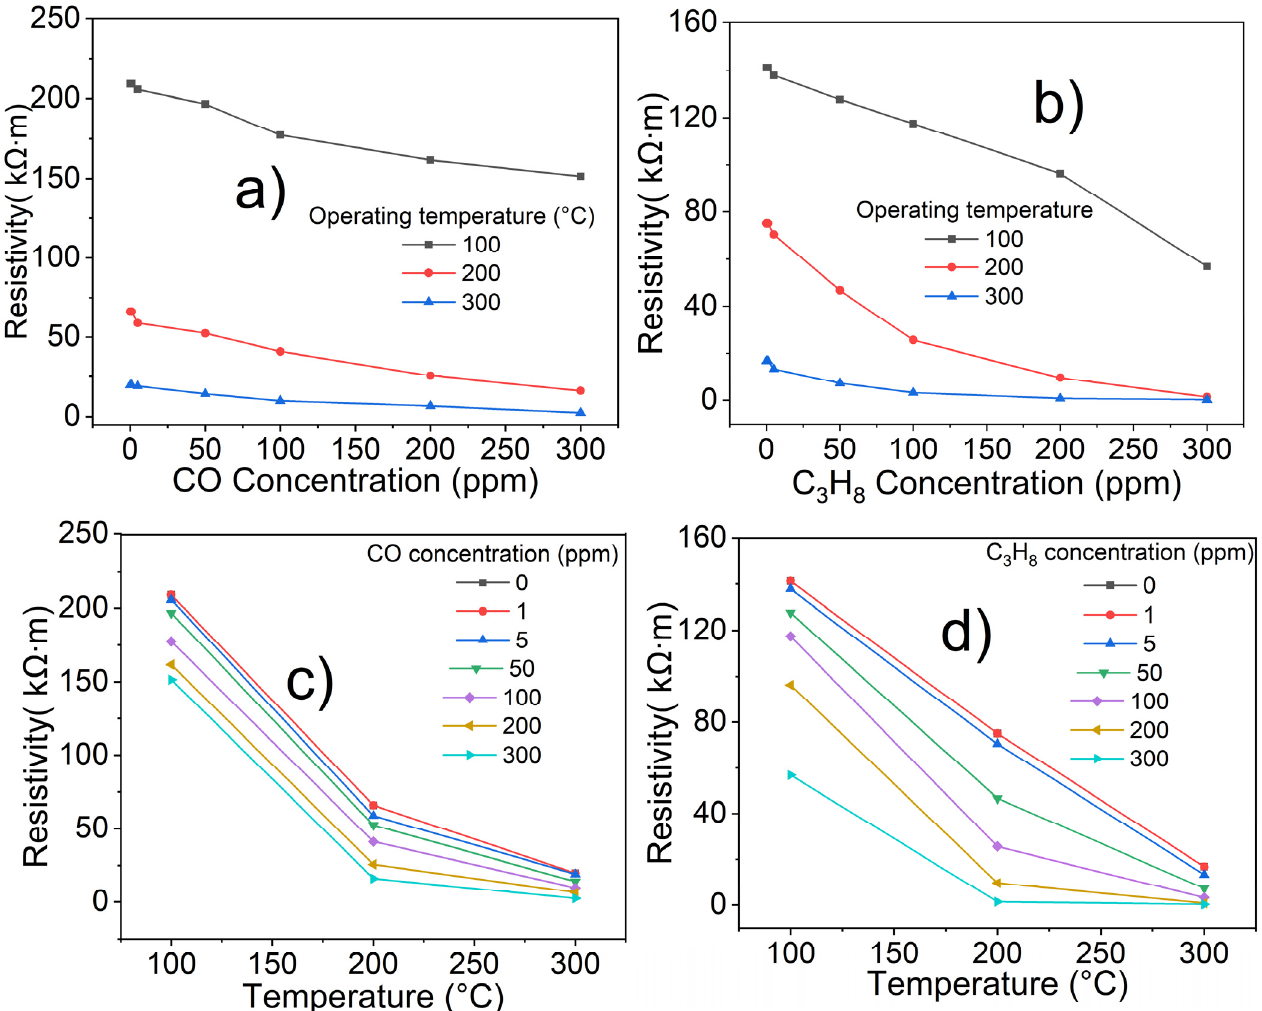
Figure 15. Variation in electrical resistivity ( ρ ) of the ZnAl 2 O 4 pellets as a function of ( a ) CO concen- tration, ( b ) propane concentration, ( c ) CO temperature, and ( d ) propane temperature.